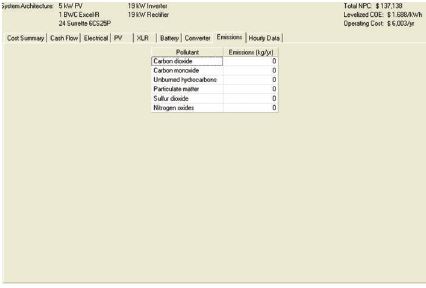
Figure 16: Emission output